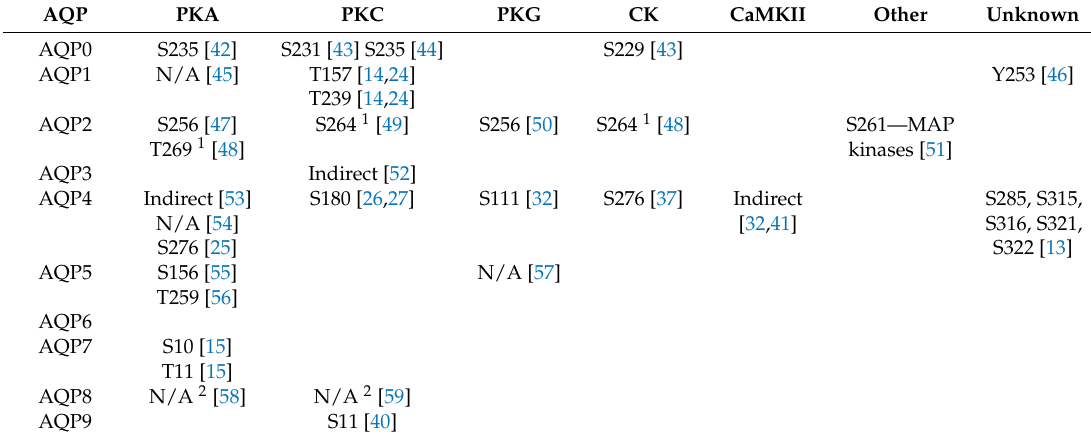
Kinases and phosphorylation sites involved in regulation of mammalian AQP0-9. PKA—protein kinase A; PKC—protein kinase C; PKG—protein kinase G; CK—casein kinases; CaMKII—calmodulin-kinase II; N/A—residue information not available. Phosphorylation of